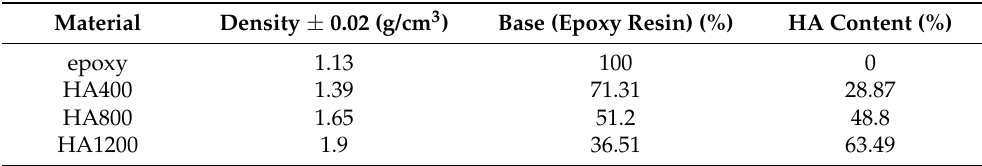
Figure 2. Schematic of the simulated phantom in the XY plane (top row) and in the XZ plane (bottom row) consisting of ( a ) epoxy and HA400, ( b ) epoxy and HA800, and ( c ) epoxy and HA1200. The plane orientation is depicted in the top left corner. Table 1. Composition and density for the components of the phantom samples (used for both simulation and experimental studies). The manufacturer for the experimental phantom was QRM GmbH, Germany